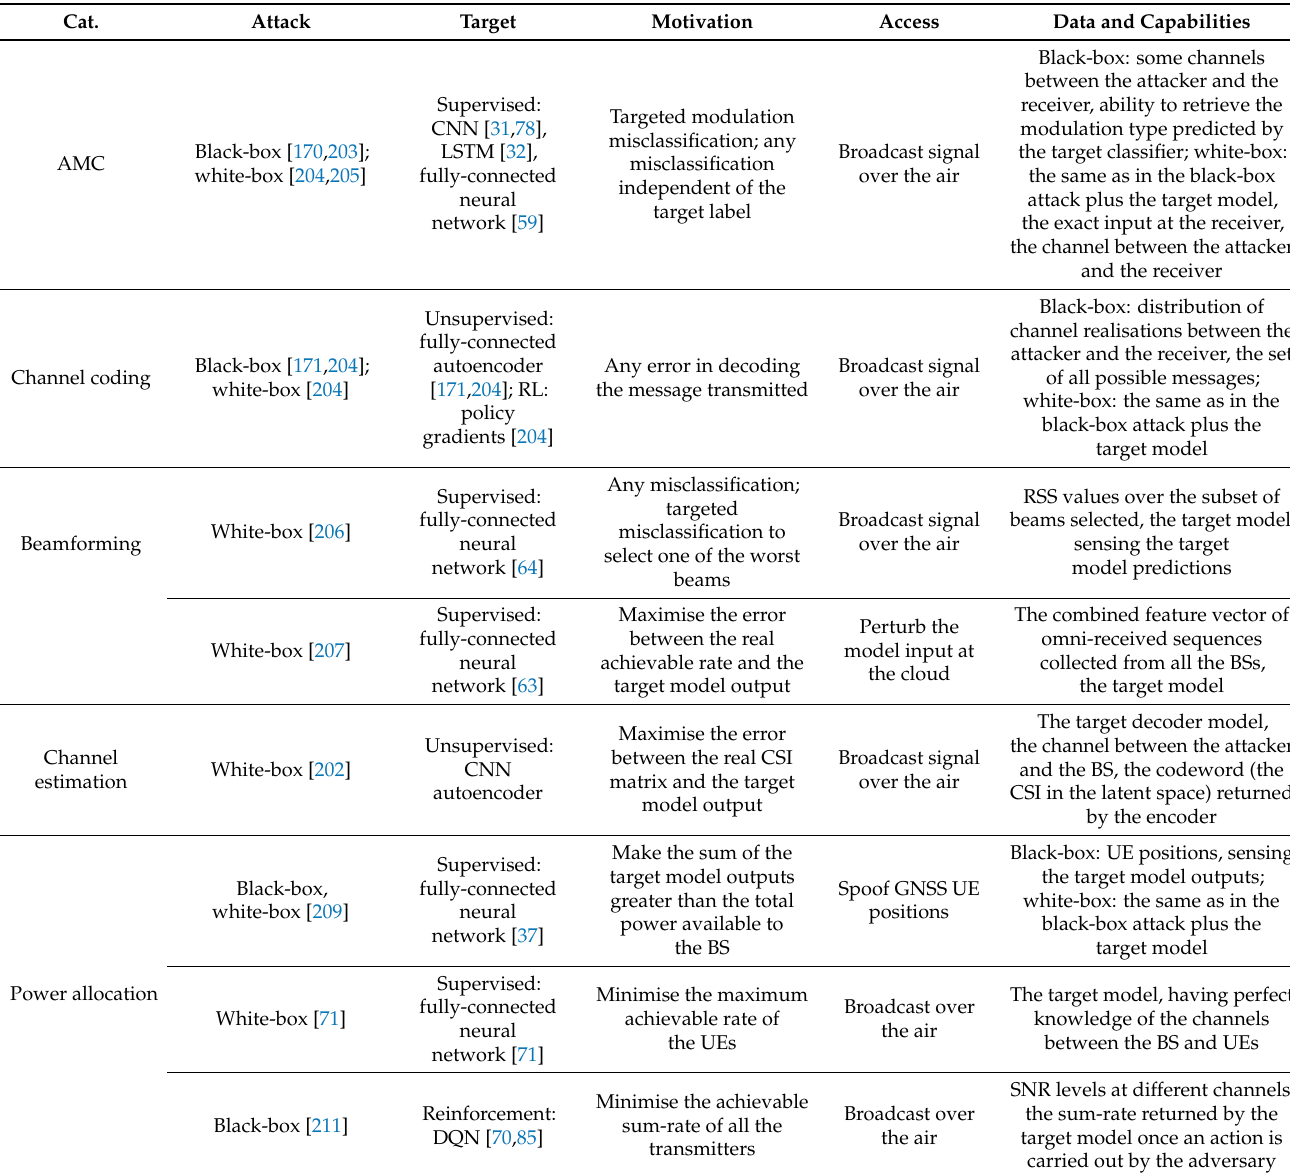
Table 5. Adversarial example generation attacks against 5G